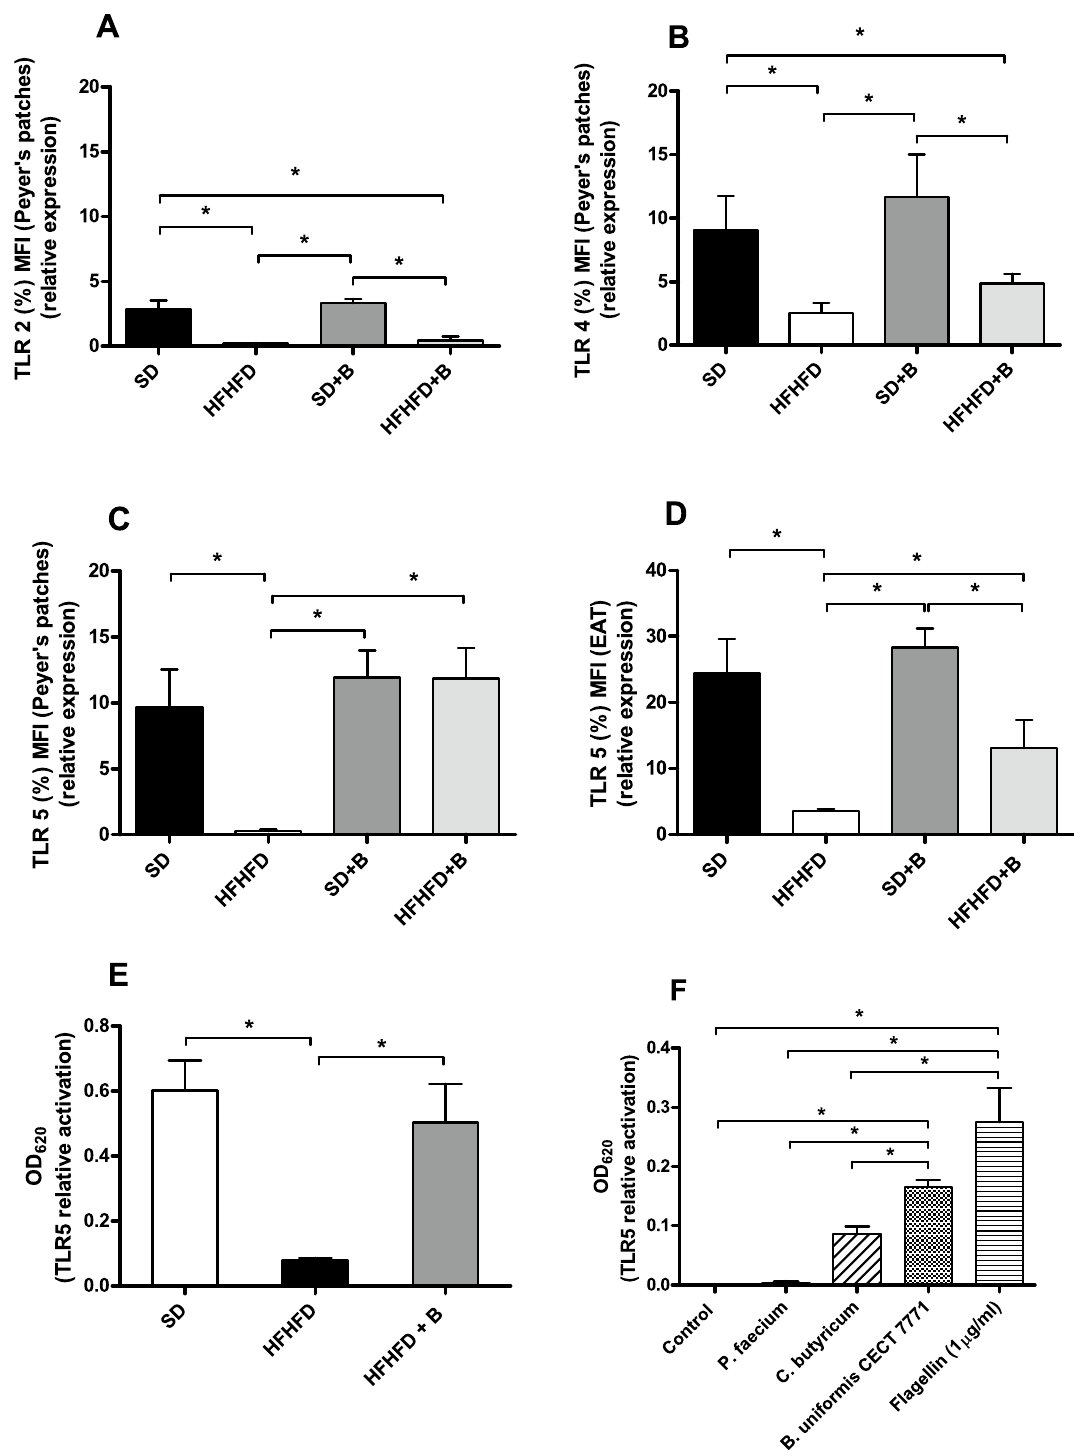
Figure 3. Relative expression of ( A ) TLR2, ( B ) TLR4 and ( C ) TLR5 from Peyer´s patches and ( D ) TLR5 from epididymal adipose tissue. Relative activation of TLR5 using HEK-Blue hTLR5 cells with ( E ) fecal samples from the SD, HFHFD and HFHFD + B experimental groups and ( F ) individual bacterial cultures of Phascolarctobacterium faecium (negative control), Clostridium butyricum (positive control), B. uniformis CECT 7771, and recombinant flagellin (RecFLA-ST, 1 μg/ml) (positive control). Control samples consisting of endotoxin-free water were included as negative controls. Data are expressed as mean and standard error (vertical bars). Statistically significant differences were established by ANOVA and post hoc student t test ( p <